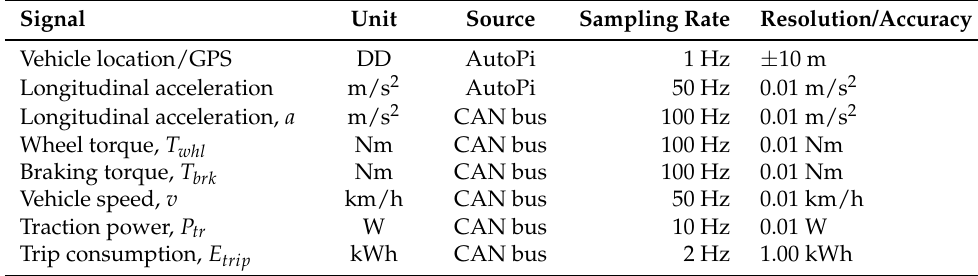
Table 3. Description of EV signals utilized in the present